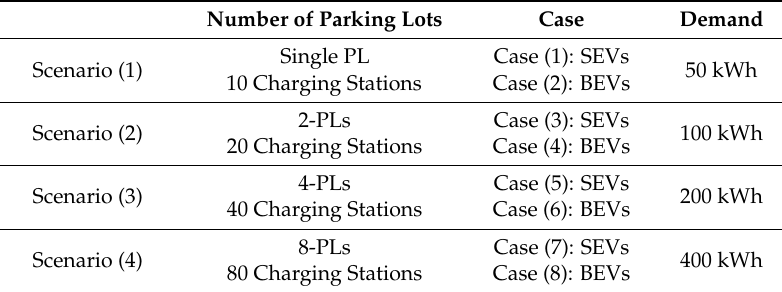
Table 5. Simulation scenarios.